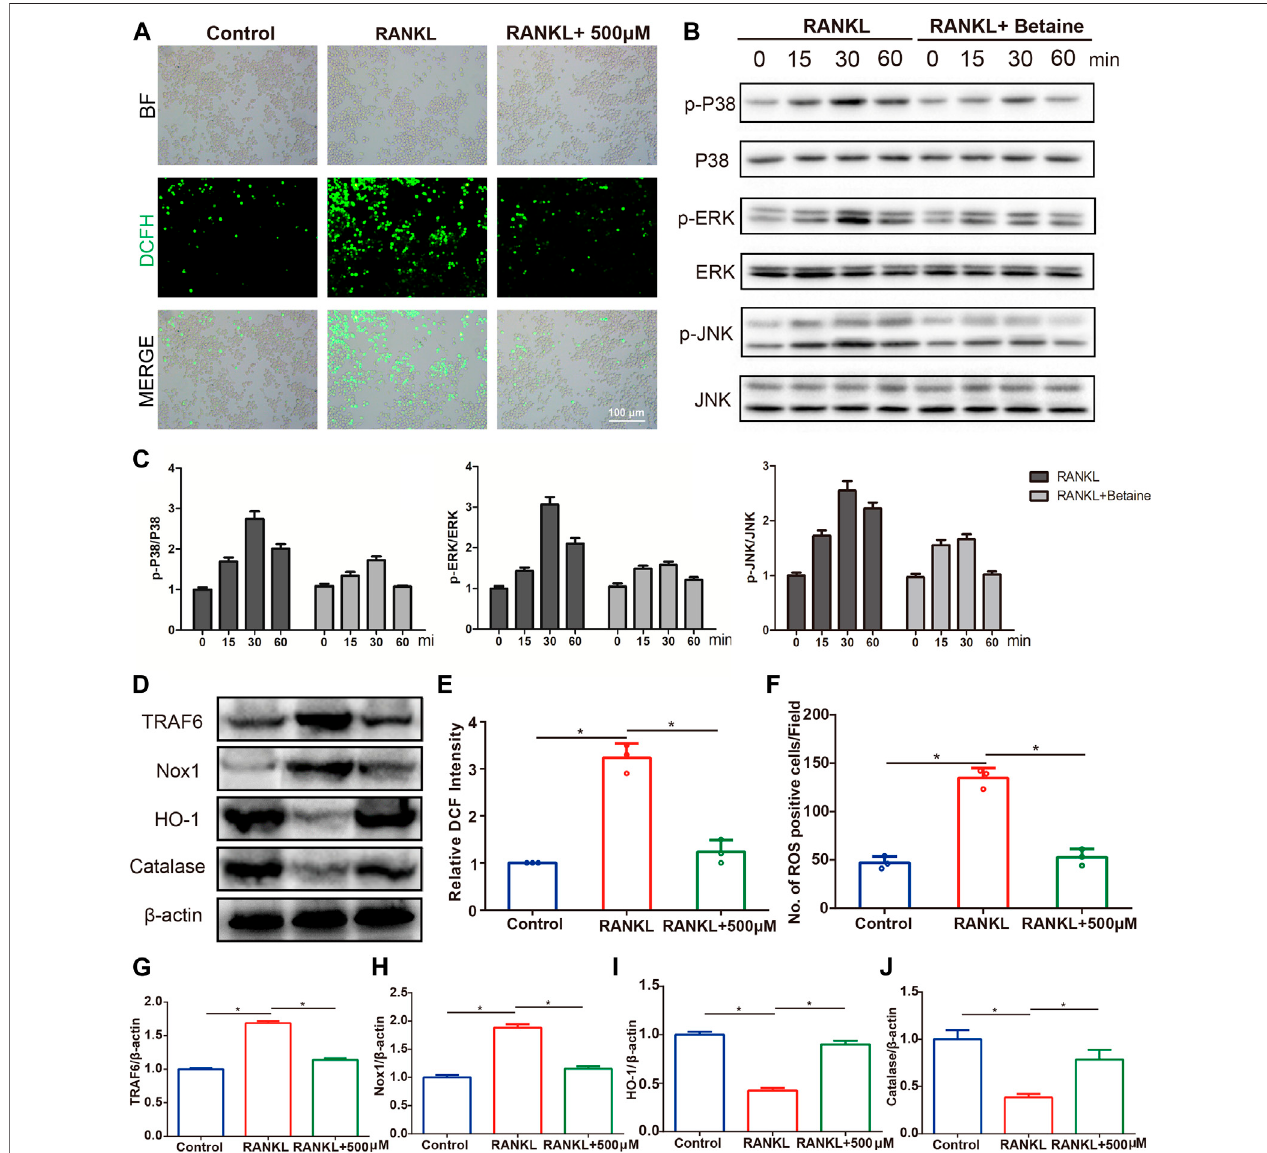
FIGURE 7 | Betaine inhibits RANKL-induced activation of reactive oxygen species (ROS) and MAPK signaling pathway. (A) Representative images of ROS productioninBMMCswithorwithoutbetainetreatment.BF,bright fi eld.DCFH-DA,2 ′ ,7 ′ -dichloro fl uorescindiacetate.Scalebar,100 μ m. (B,C) Westernblotanalysisof the phosphorylation of ERK, P38, and JNK in different groups and time points. (D) Western blot analysis of the expression levels of TRAF6, Nox1, HO-1 and Catalase in different groups. (E,F) Quantitative analysis of relative DCF intensity and the number of ROS positive cells per fi eld. (G – J) Quanti fi cation of the expression levels of TRAF6, Nox1, HO-1 and Catalase. * p < 0.05 as denoted by